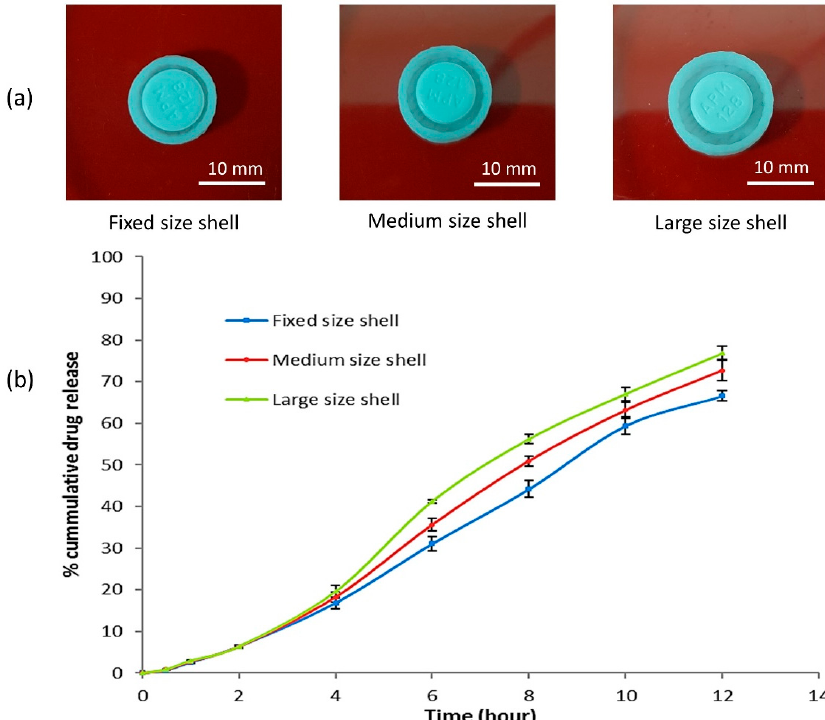
Figure 5. ( a ) Different sizes of 3D printed controlled-release shells illustrating the gap/space between the enclosed tablet and the shell wall. ( b ) Cumulative release of propranolol HCl with phosphate buffer (pH 6.8) as dissolution media at temperature 37 ± 0.5 °C from 3D printed controlled-release shells of different sizes. Table 5. In vitro release kinetics of propranolol HCl from 3D printed controlled-release shells of variable composition and size fitted to the best-fit release kinetic